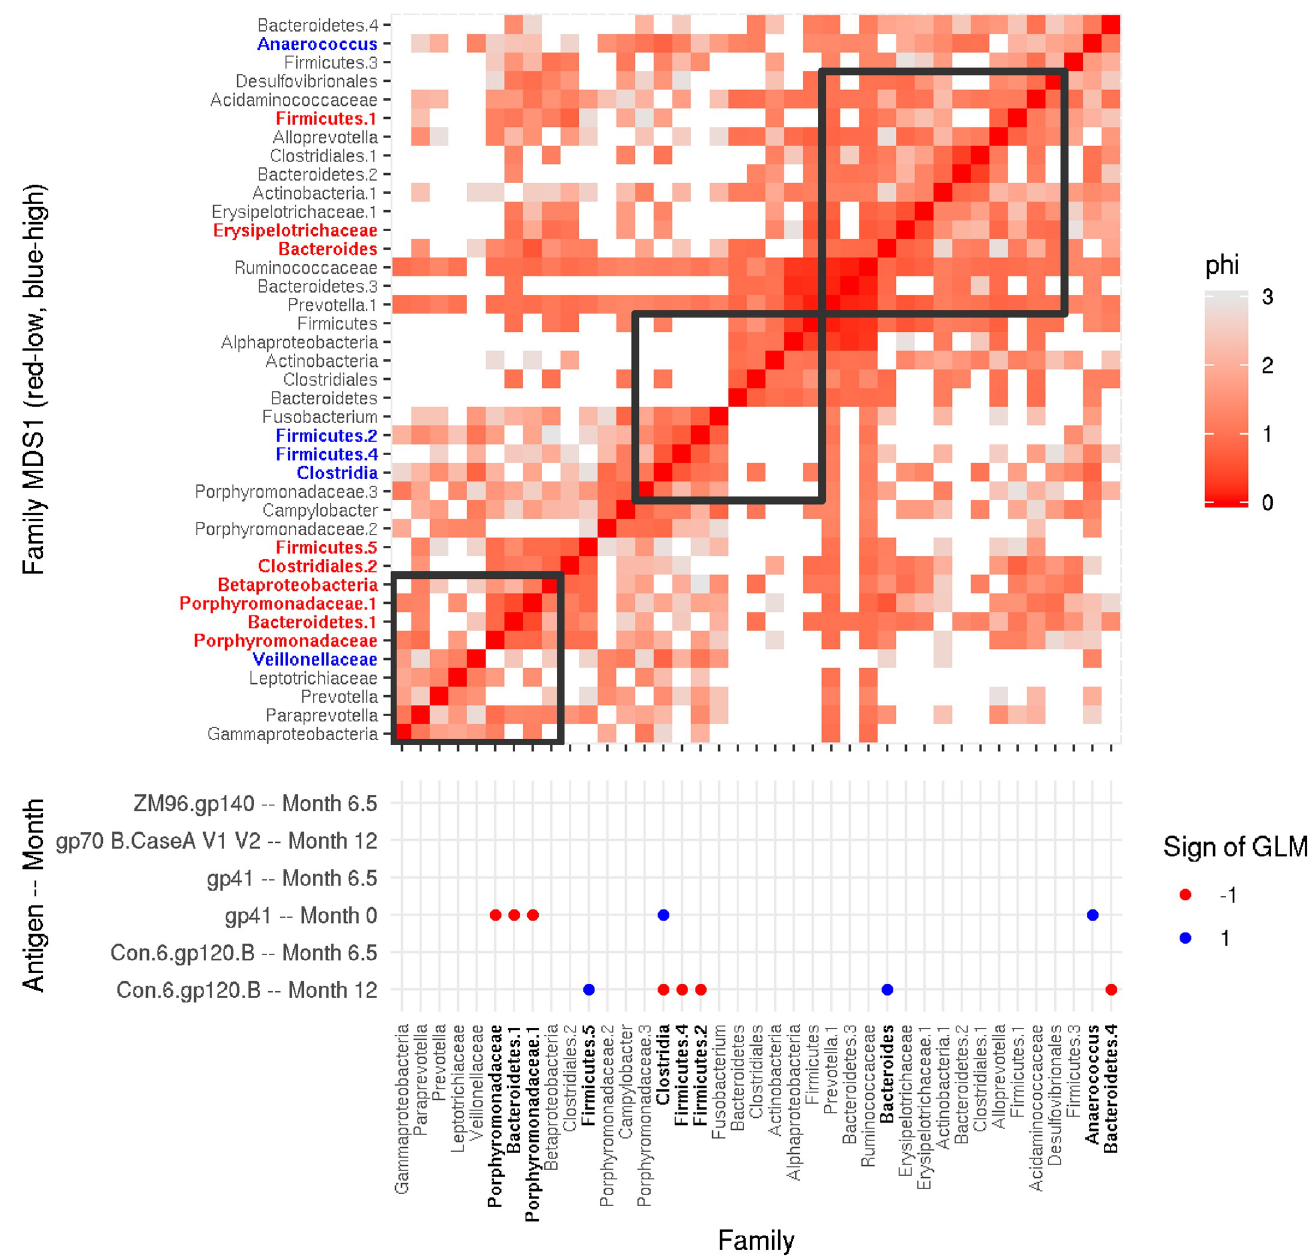
Fig 5. Family level groups fall into three proportional clusters, two of which are associated, in opposite ways, with magnitude of IgG responses as demonstrated by a Heat-map of F [26], a measure of proportionality between different family level groups. In the upper panel (heatmap), each row and column are a family level taxon. Redder cells indicate lower F scores, which demonstrate higher statistical association between the pair of families. Three proportional clusters (surrounded by squares) can be seen. The dots in the lower panel (dot-grid) indicate IgG binding antibodies specific to each antigen at each time points (y-axis) that associate with each family level taxon (x-axis) ( p < 0.05, FDR < 0.2). Blue dots indicate that a family level group is positively associated with a particular antibody response at a given time point, while red dots indicate negative associations. Slope coefficients of these logistic associations are reported in S6 Fig. Bacterial families in the top right cluster associate positively with magnitude of response to the vaccine target antigens Con.6.Gp120.B, gp70 B.Case A V1-V2, and ZM96.gp140 and gp41 at month 6.1 and negatively to gp41 at baseline. The middle cluster associate negatively with IgG response to vaccine target antigens and positively to gp41 baseline response. The lower left cluster does not appear to associate with any of the antigens.